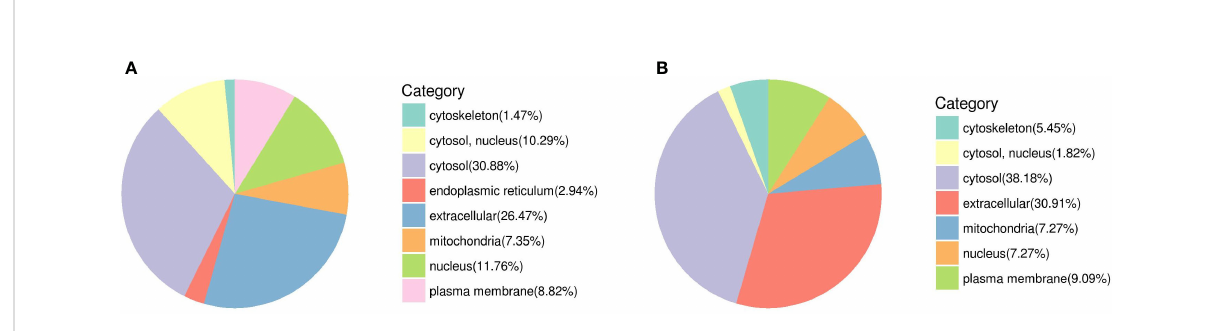
FIGURE 8 DEP category distribution for subcellular location. (A) Female; (B)